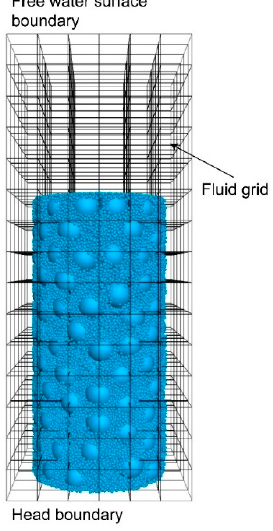
Figure 9. Cell grid model.